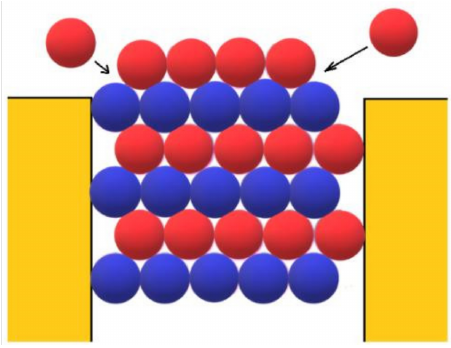
Figure 3. HCP crystal emerging from a pore having the shape of a rectangular prism (side view, as in Figure 1). The alternate layers are hexagonal A (blue balls) and ditrigonal B (red balls). Protein molecules are attached (at places shown by the arrows) to the crystal for growth outside the pore.